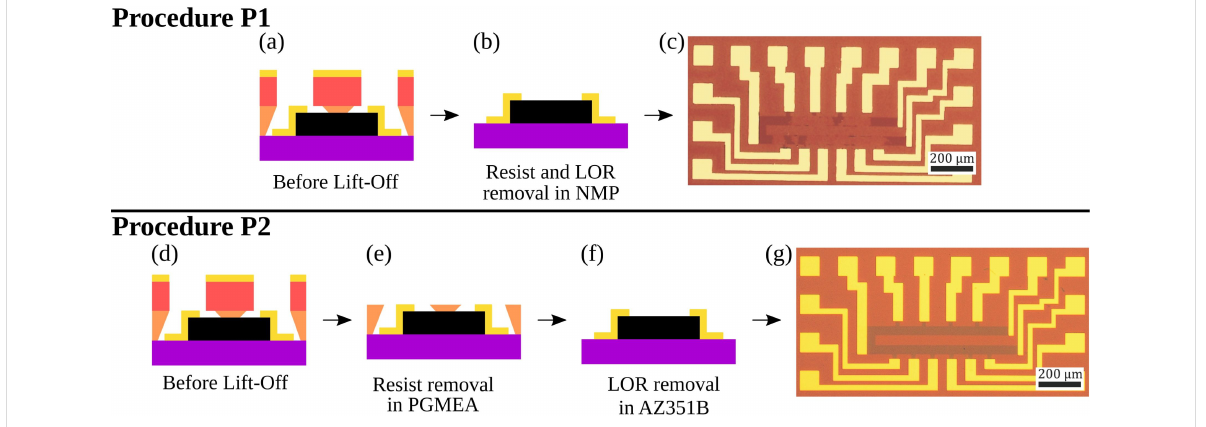
Figure 2: Procedures P1 and P2 for photoresist removal and lift-off. Procedure P1: (a, b) The LOR/resist layer was removed in an unique step, using NMP, followed by rinsing in IPA and DI. c) Graphene device after lift-off; Procedure P2: d) The resist layer was removed first using 1-methoxy-2- propanol acetate (PGMEA), then the graphene device was washed out in IPA and DI. e) and f) Next, the LOR layer was removed in AZ351B, fol- lowed by rinsing in IPA and DI. g) Devices with continuous graphene were obtained by procedure P2. The scale bars shown in c) and g) measure 200 μ m.